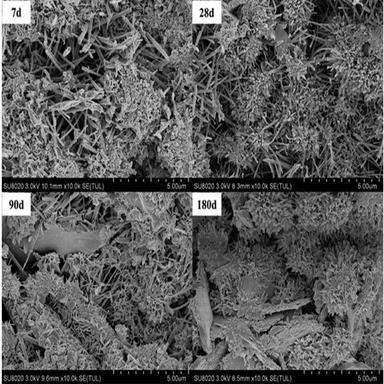
Micrograph of sample RFG-5 cured for 7d, 28d, 90d, 180d.